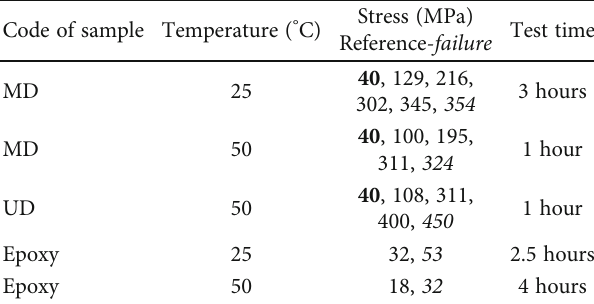
Table 2: Condition of creep tests on the MD and UD